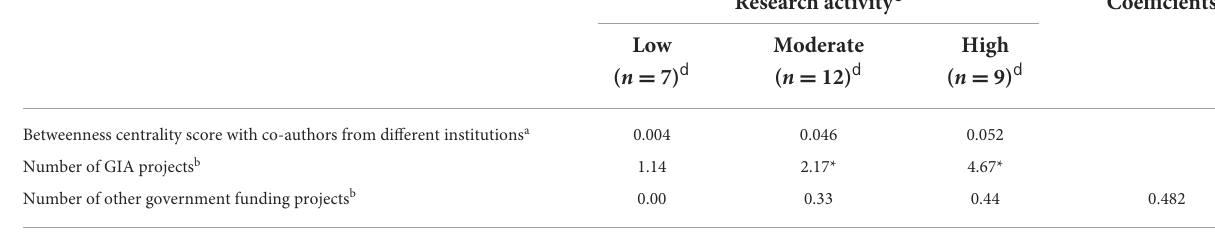
TABLE 6 Visibility in academic fields and competitiveness in funding